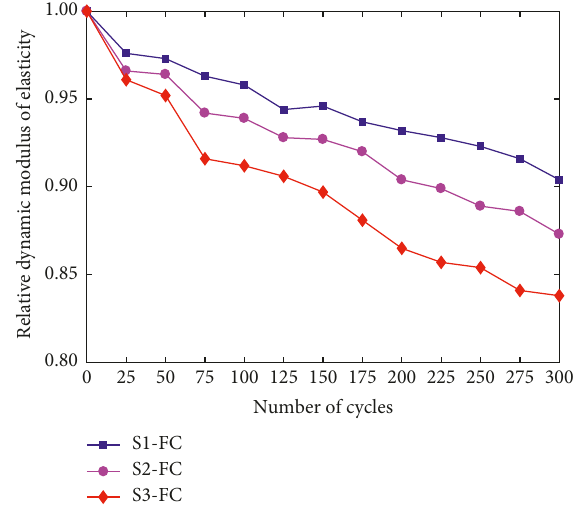
Figure 1: Relative dynamic modulus of elasticity of S1, S2, and S3 in FC mode. S2 in different testing modes.